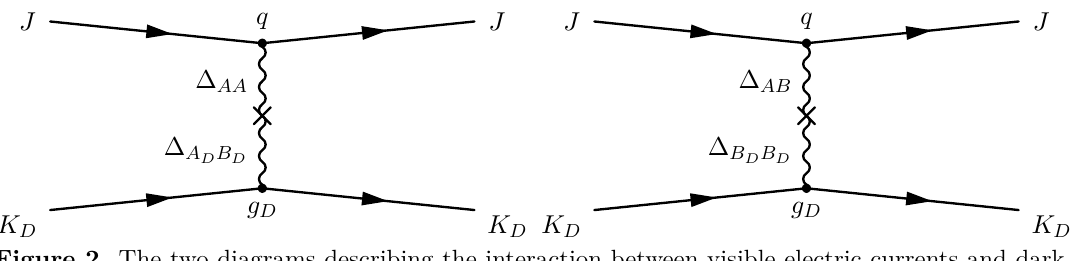
Figure 2 . The two diagrams describing the interaction between visible electric currents and dark magnetic currents. Scattering proceeds through A - A D mixing (left) and B - B D mixing